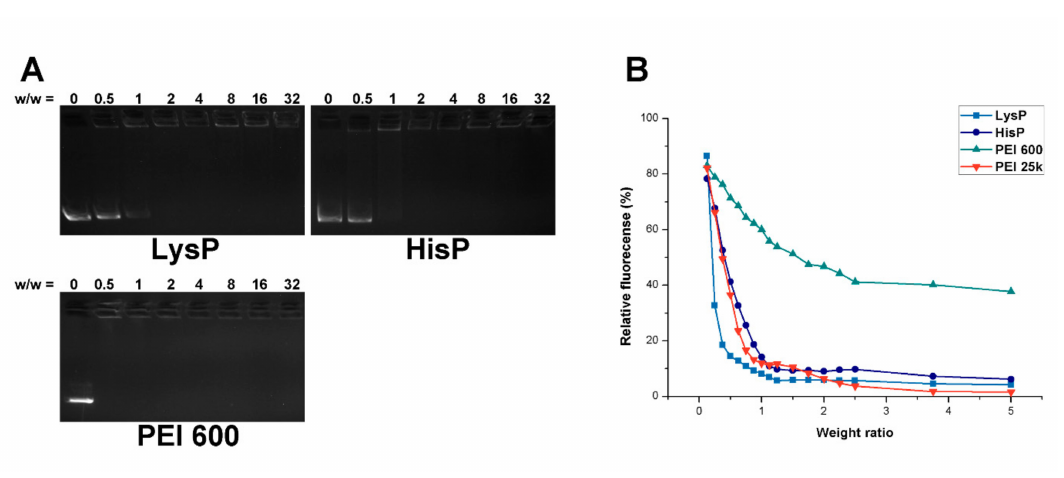
Figure 1. ( A ) Agarose gel electrophoresis of cationic polymers complexed with DNA at di ff erent weight ratios. ( B ) Fluorescence quenching assay by the addition of